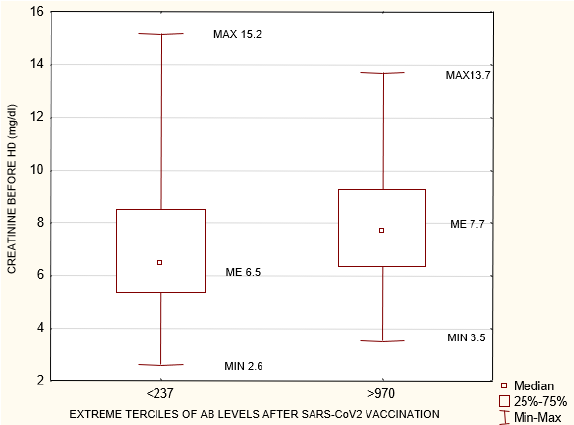
Figure 7. Statistically significant differences in creatinine concentration (mg/dL) before HD between the extreme terciles of AB levels after SARS-CoV-2 vaccination <237 AU/mL and >970 AU/mL p = 0.03. Mann–Whitney U test. AB: antibody. Table 5. Statistically significant differences within the group of patients who had no SARS-CoV-2 infection prior to vaccination. They were divided into patients below and those above or equal the median AB level following vaccination ME 570 AU/mL.